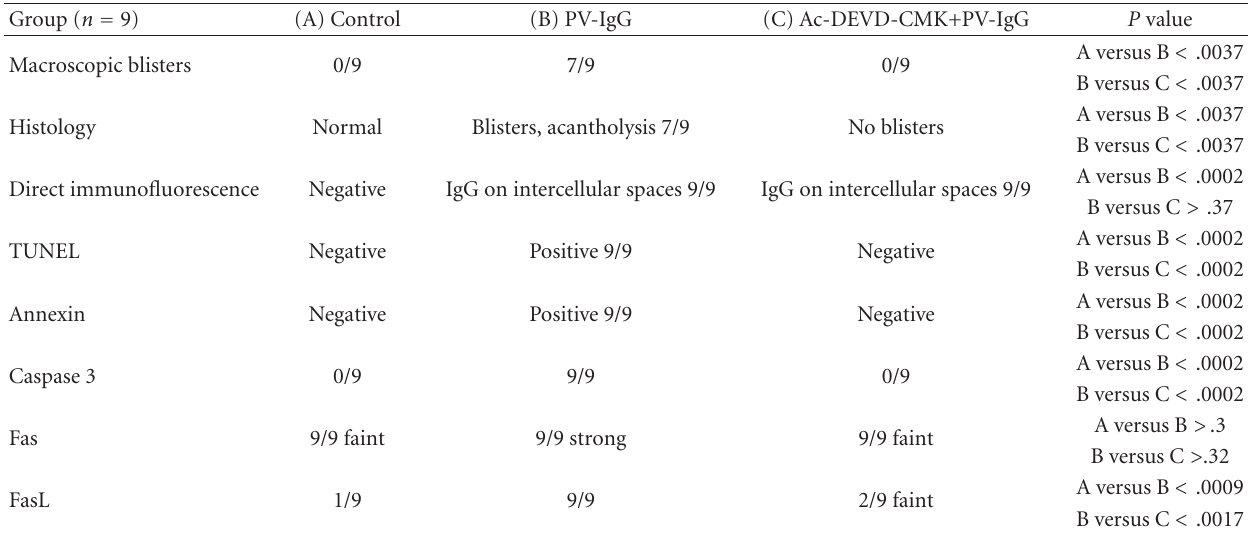
Table 1: Pemphigus IgG triggers acantholysis in Balb/c